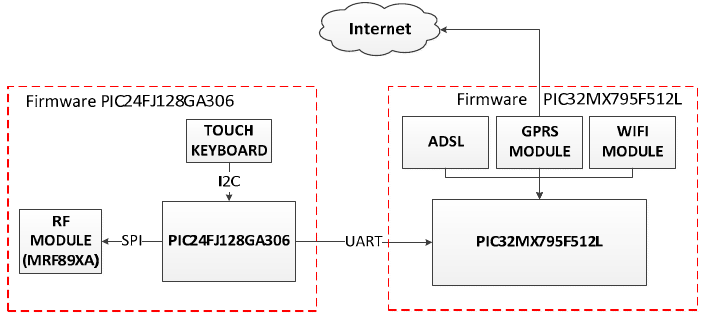
Figure 4. Block diagram of the firmware structure of the base station.